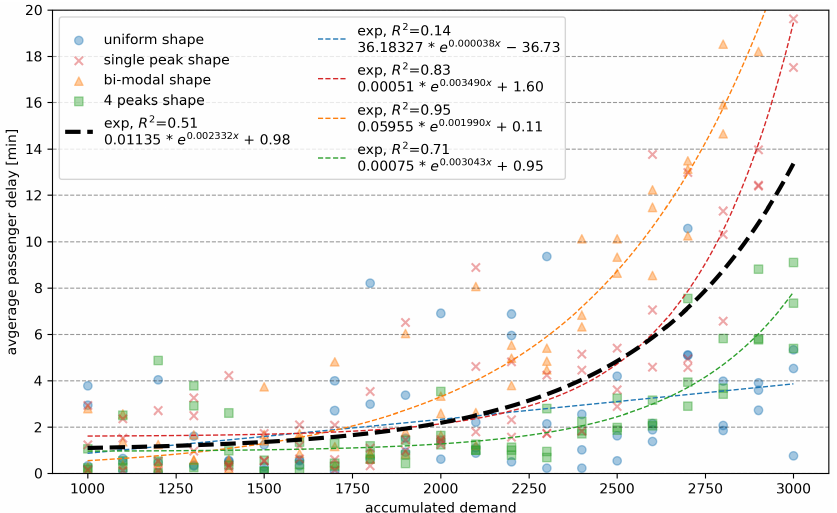
Figure 5. Analyzing the effect of accumulated daily demand on the average passenger